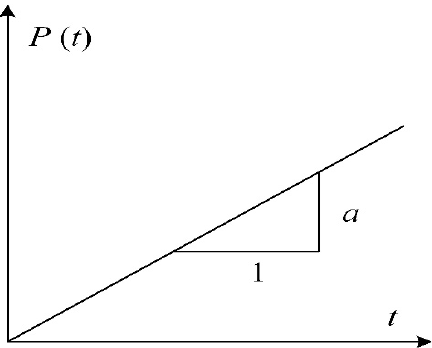
Figure 6. Relationship between dynamic load and loading time.